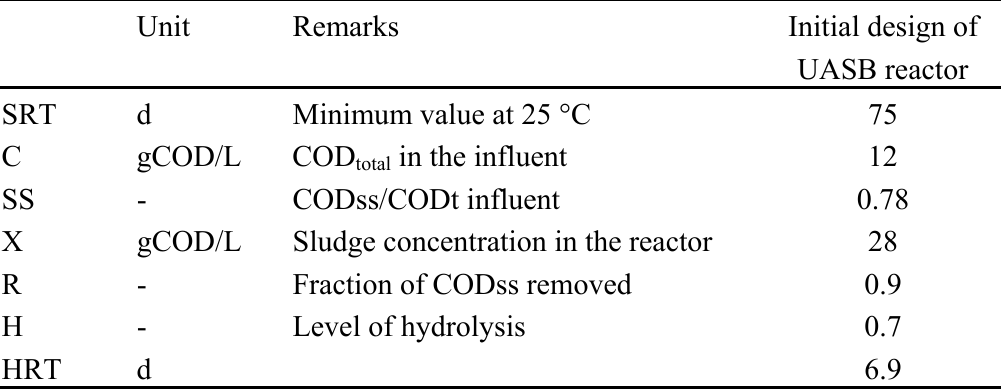
Table 2. Initial design values for the UASB